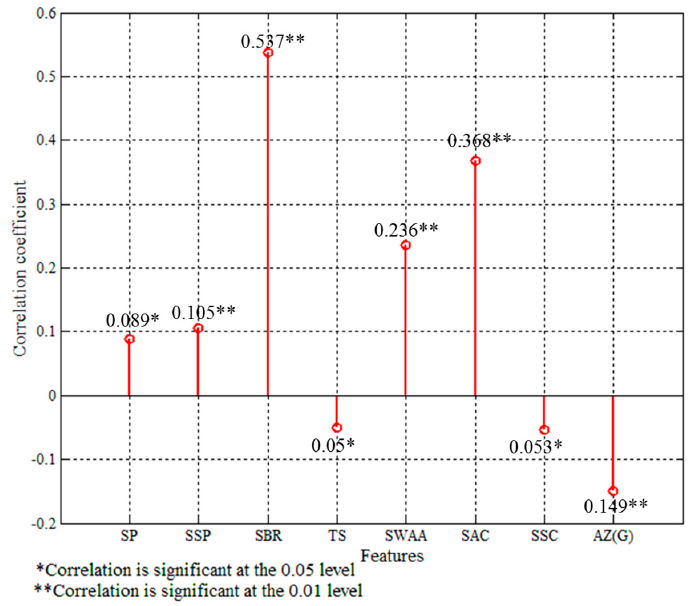
Figure 9. The correlations between eight selected features and traffic events. Table 3. The results of partial correlation test while control the variable of traffic event.